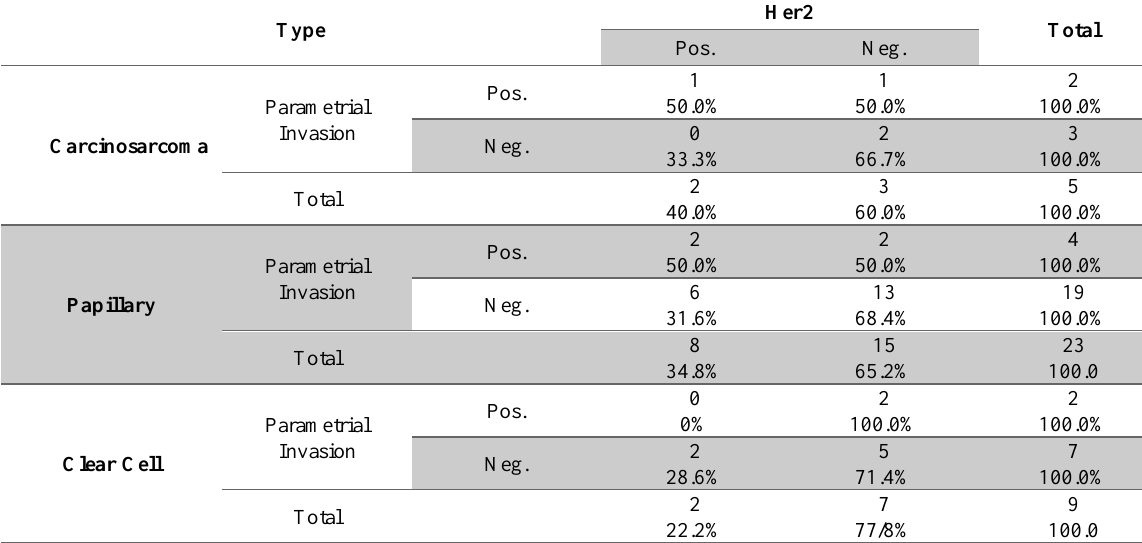
Table 6. Her2/neu overexpression and parametrial